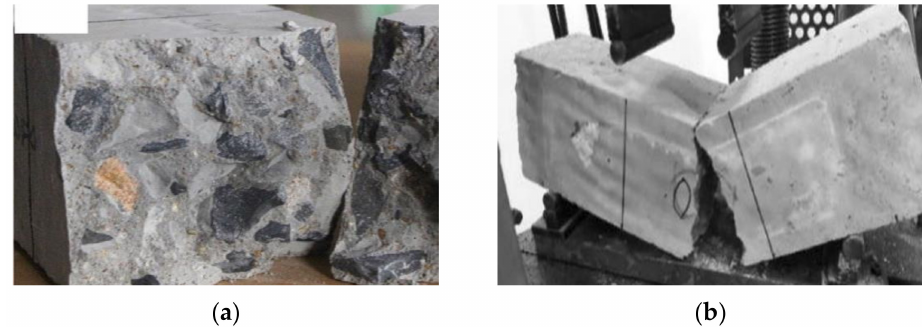
Figure 6. Flexural failure of concrete without fibers: ( a ) [88]; ( b ) [89].